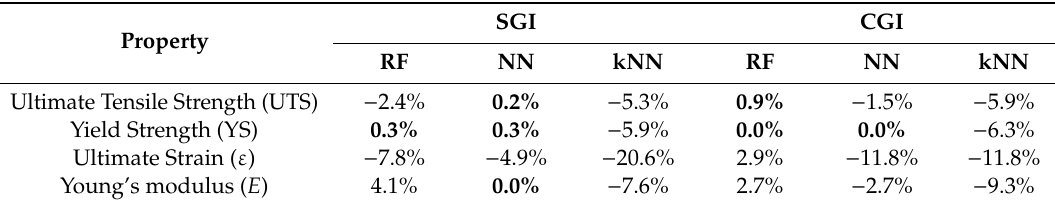
Table 7. Error estimation in the prediction of mean values.